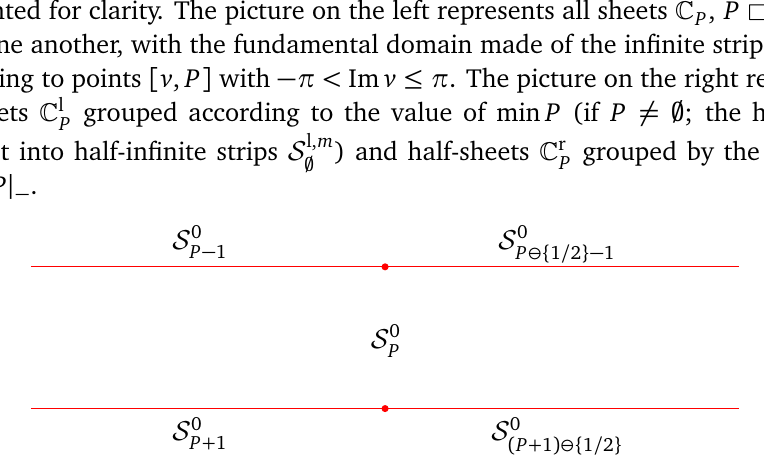
, P (cid:64) (cid:90) + 1 / 2 partitioning the Riemann P